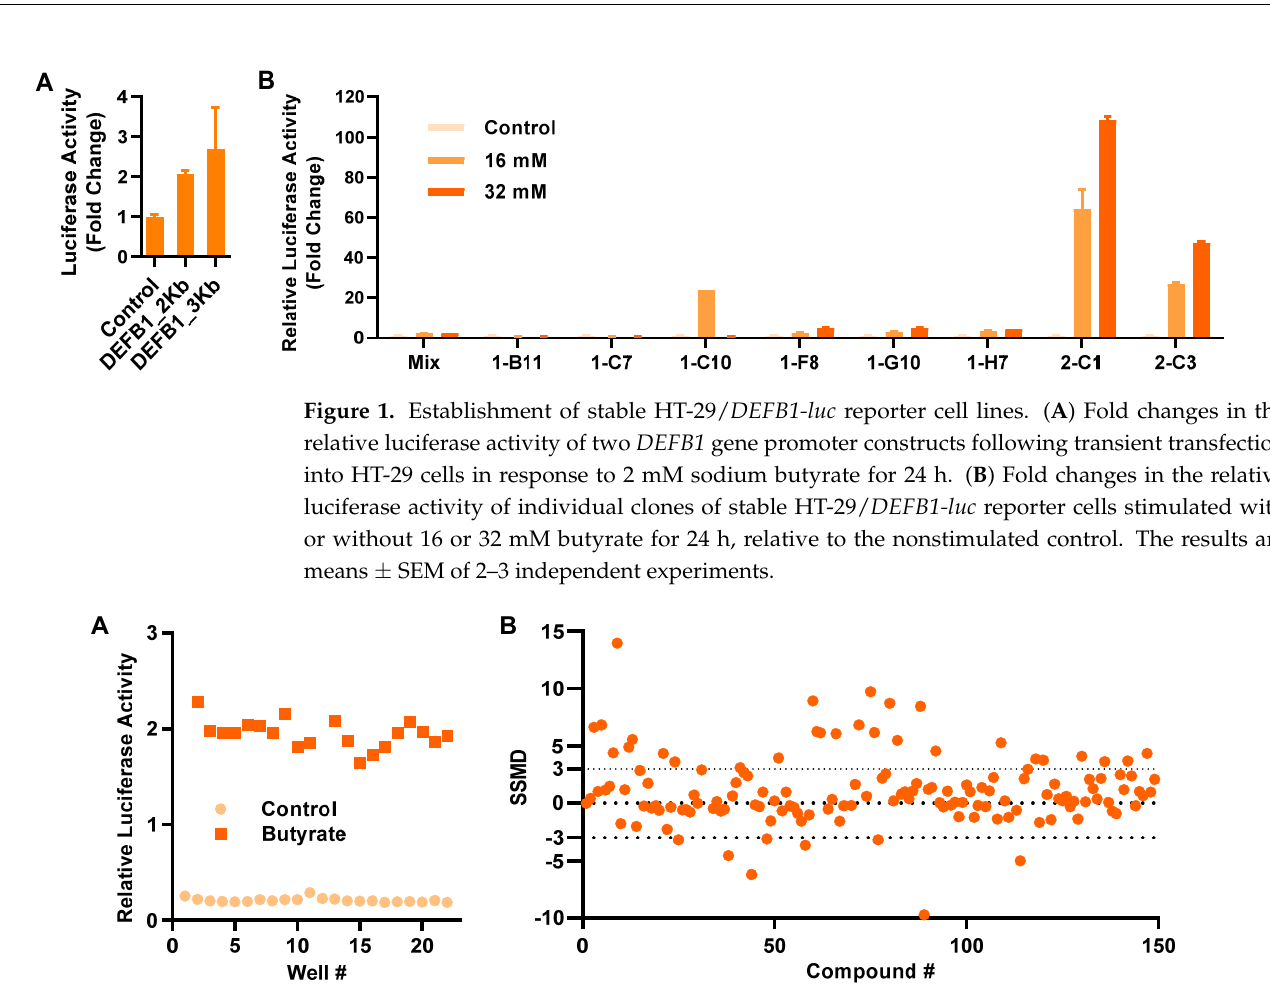
Figure 2. Development of a cell-based high-throughput screening assay to identify HDP-inducing compounds. ( A ) Relative luciferase activity of HT-29/ DEFB1-luc cells stimulated with or without 16 mM butyrate for 24 h for calculation of Z’-factor. ( B ) Normalized strictly standardized mean difference (SSMD) values of 148 epigenetic compounds following an HTS assay. HT-29/ DEFB1-luc cells were stimulated with 20 μ M of each compound for 24 h, followed by cell viability and luciferase assays. The SSMD value was calculated for each compound from its luciferase activity normalized to the cell viability, as previously described [25] . The dotted lines indicate the threshold for the selection of hits.